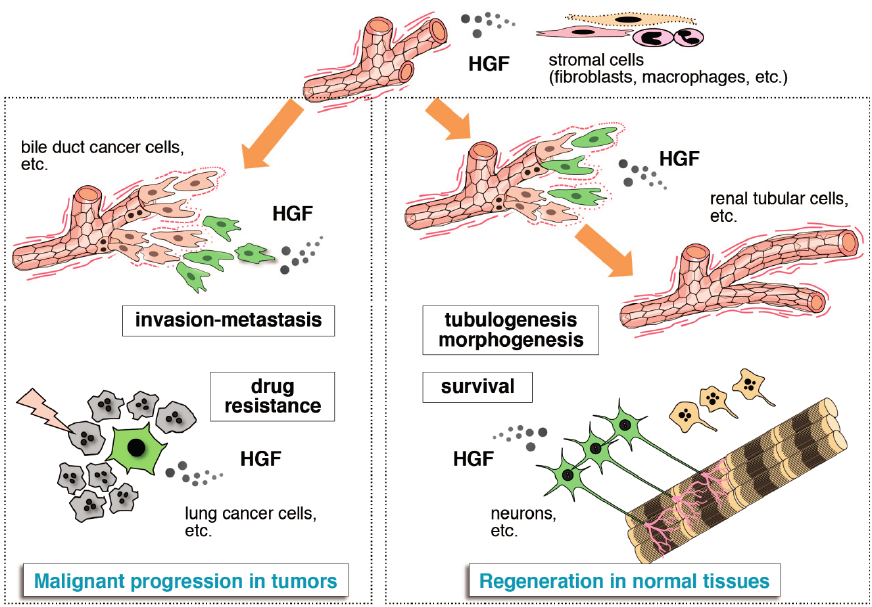
Figure 3. Two-pronged roles of HGF in tissue regeneration and cancer tissues. HGF is mainly expressed in stromal cells. Cells responding to HGF are conceptually shown in green. Dynamic morphogenesis (e.g., blanching tubulogenesis in renal tubular cells) and promotion of cell survival (e.g., for neurons) mediated by the HGF–Met pathway play roles in tissue regeneration after tissue injury ( right part ). Dynamic cell movement and survival promoted by Met activation participate in invasion-metastasis and resistance to anticancer drugs in cancer tissues ( left part